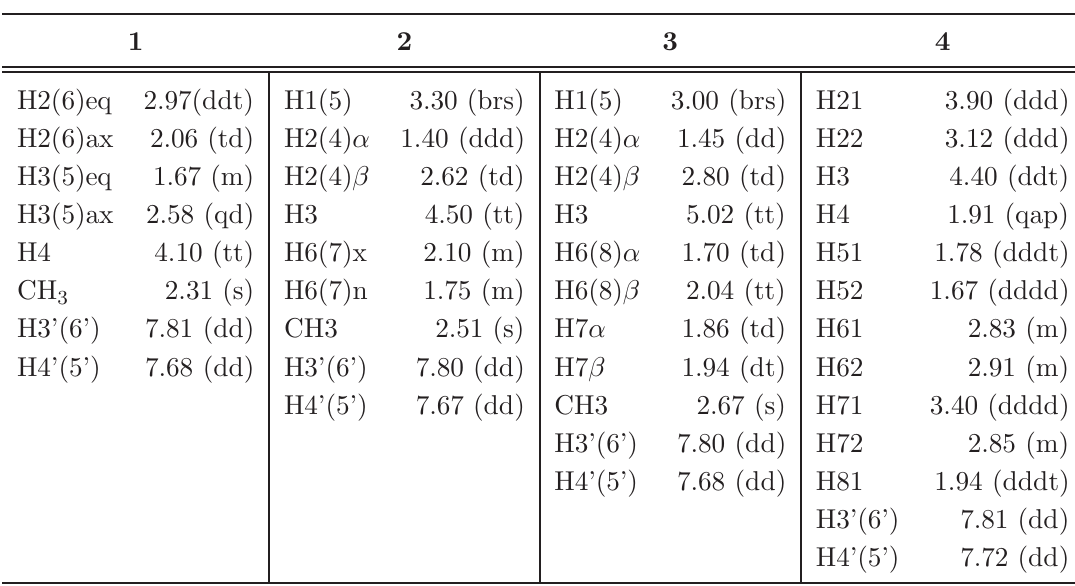
Table 1 1 H Chemical shifts ( δ , ppm) for compounds 1-4 in CDCl 3 . Abbreviations: brs, broad singlet; dd, doublet of doublets; ddd, doublet of doublet of doublets; dddd, double of double doublet of doublets; dt, doublet of triplets; ddt, doublet of doublet of triplets; dddt, double of double doublet of triplets; m, multiplet; qap, apparent quartet; qd, quartet of doublets; s, singlet; td, triplet of doublets; tt, triplet of